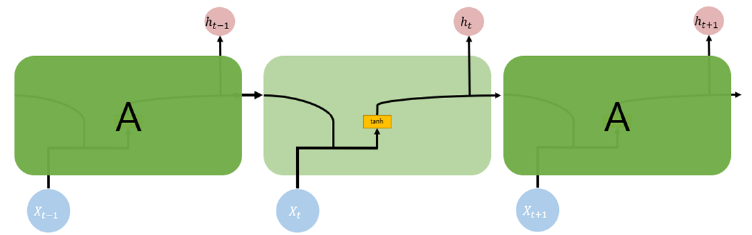
Figure 8. RNN block.